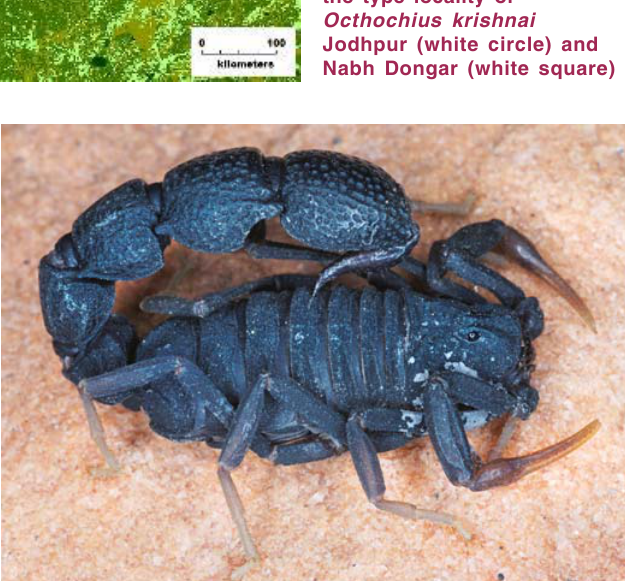
Map of Rajasthan showing the type locality of Octhochius krishnai Jodhpur (white circle)